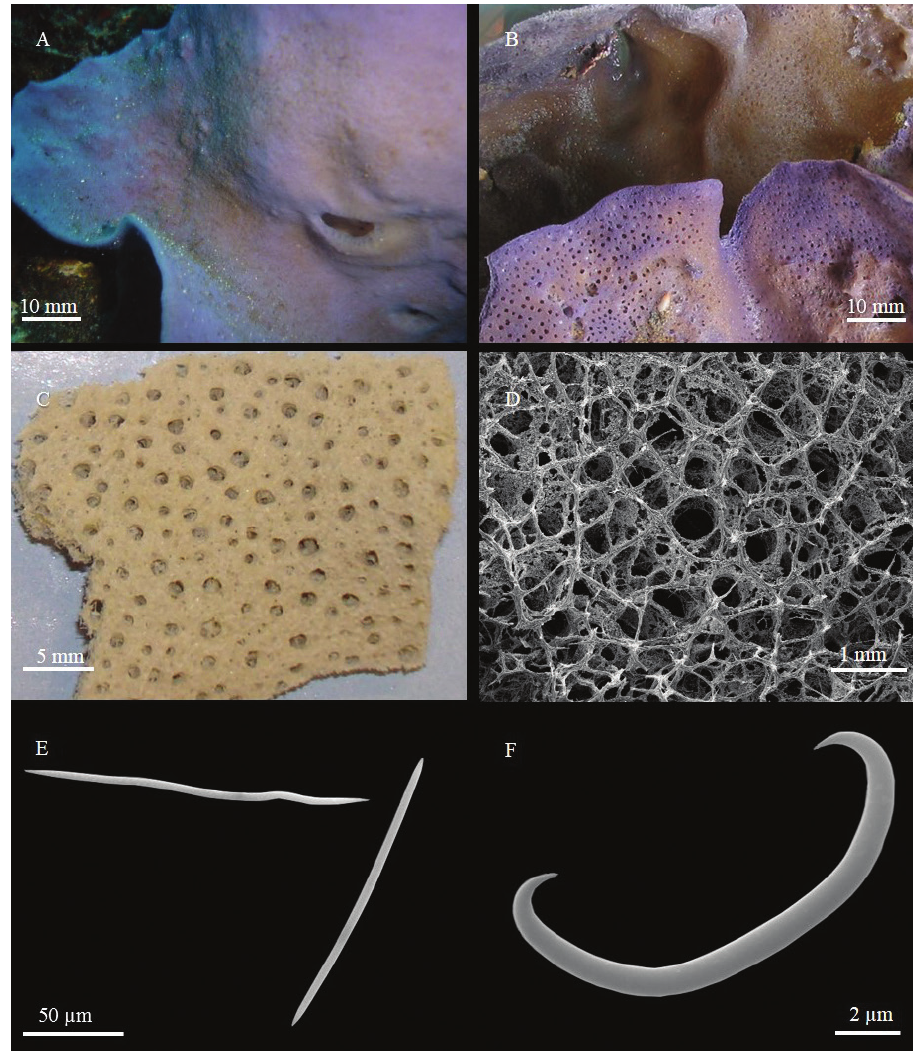
Figure 8. Niphates laminaris sp. n. A holotype in situ B, C holotype freshly collected showing the exhal- ant side of the sponge D sponge skeleton on the exhalant side with in evidence the choanosomal ascending tracts protruding through the surface and the vents E sinuous and straight oxeas F